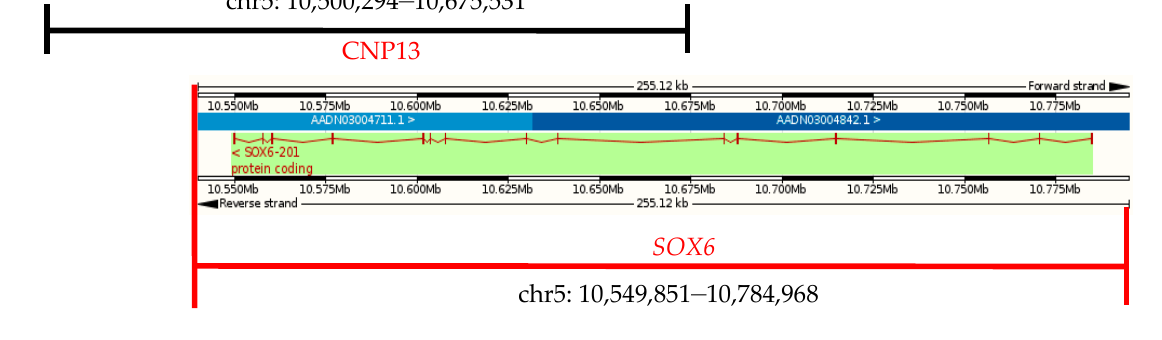
Figure 3. Gene location of chicken SOX6 .